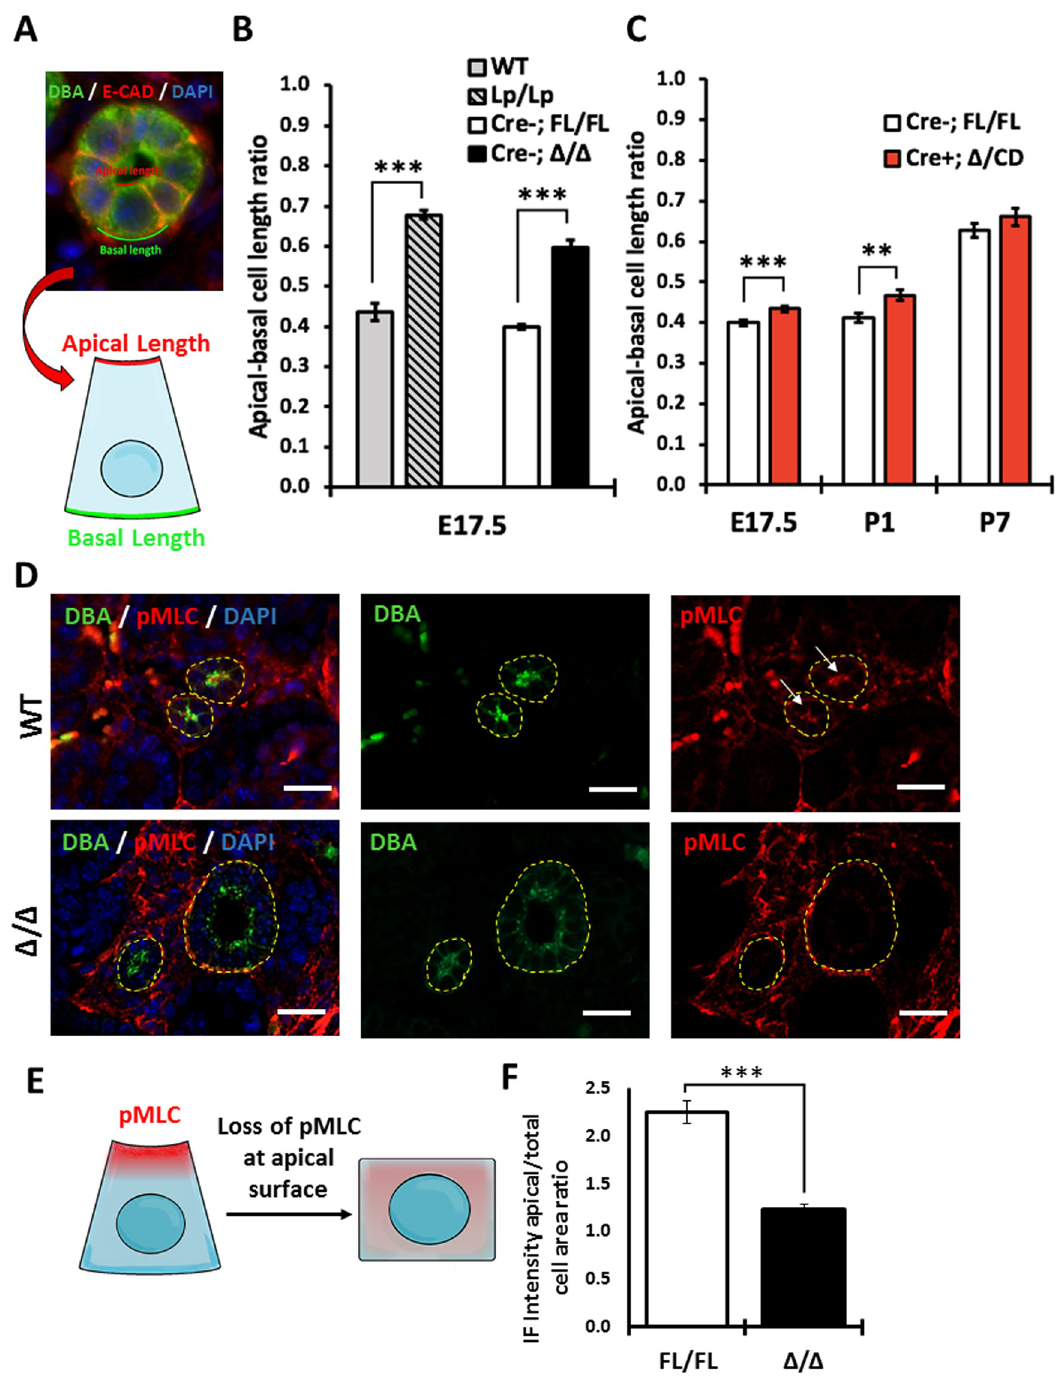
Fig 6. Analysis of apical constriction in collecting duct of Vangl2 mutant mice. (A) Immunofluorescence image (upper panel) and schematic representation (lower drawing) of the AC measurements; DBA (green), E-cadherin (red), DAPI (blue). (B) Measurements of the apical-to-basal-surface ratio in the E17.5 DBA(+) cross-sectional tubules of Vangl2 Lp/Lp (n = 456), Vangl2 Δ / Δ (n = 86), wildtype (n = 58) and Cre(-);Vangl2 Fl/Fl (n = 542) mice. (C) Measurements of the apical-to-basal-surface ratio in E17.5, P1 and P7 DBA(+) cross-sectional tubules of Vangl2 Δ /CD (E17.5 n = 525; P1 n = 107, P7 n = 82), and Cre(-);Vangl2 Fl/Fl (E17.5 n = 542; P1 n = 96, P7 n = 143) mice. (D) Immunofluorescence staining of E17.5 wildtype and Vangl2 Δ / Δ kidney sections with DBA (green, denoted in yellow line), anti-phospho-Myosin Light Chain antibody (pMLC, red) and DAPI (blue). Arrows point at the luminal pMLC enrichment in control tubules. Scale bars, 100 μ m. (E) Schematic representation of pMLC localization in control and Vangl2